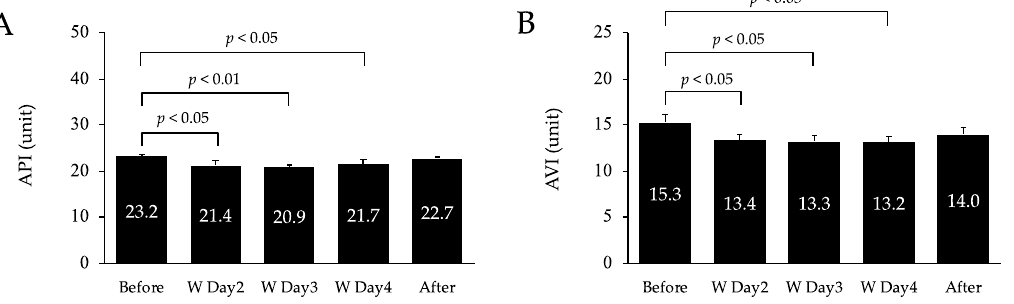
Figure 2. Changes in peripheral arterial stiffness ( A ) and systemic arterial stiffness ( B ) before, dur- ing, and after the workcation. Values are mean ± SD. W, workcation. API, arterial pressure-volume index; AVI, arterial velocity pulse index.